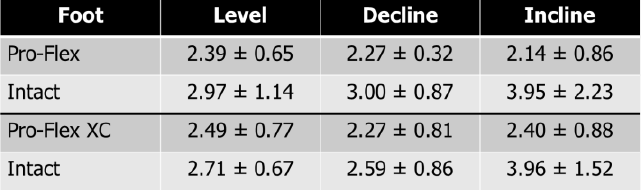
Table 2 . Mean and standard deviation for ankle push-off power